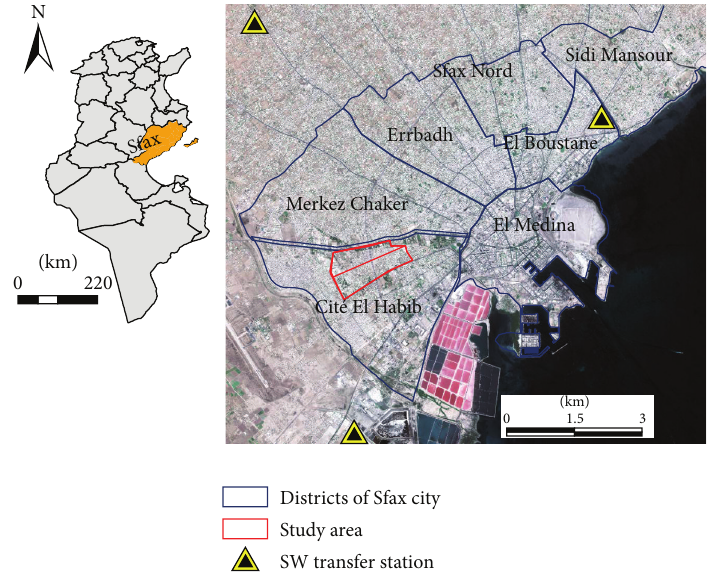
Figure 1: Sfax city and the case study area.